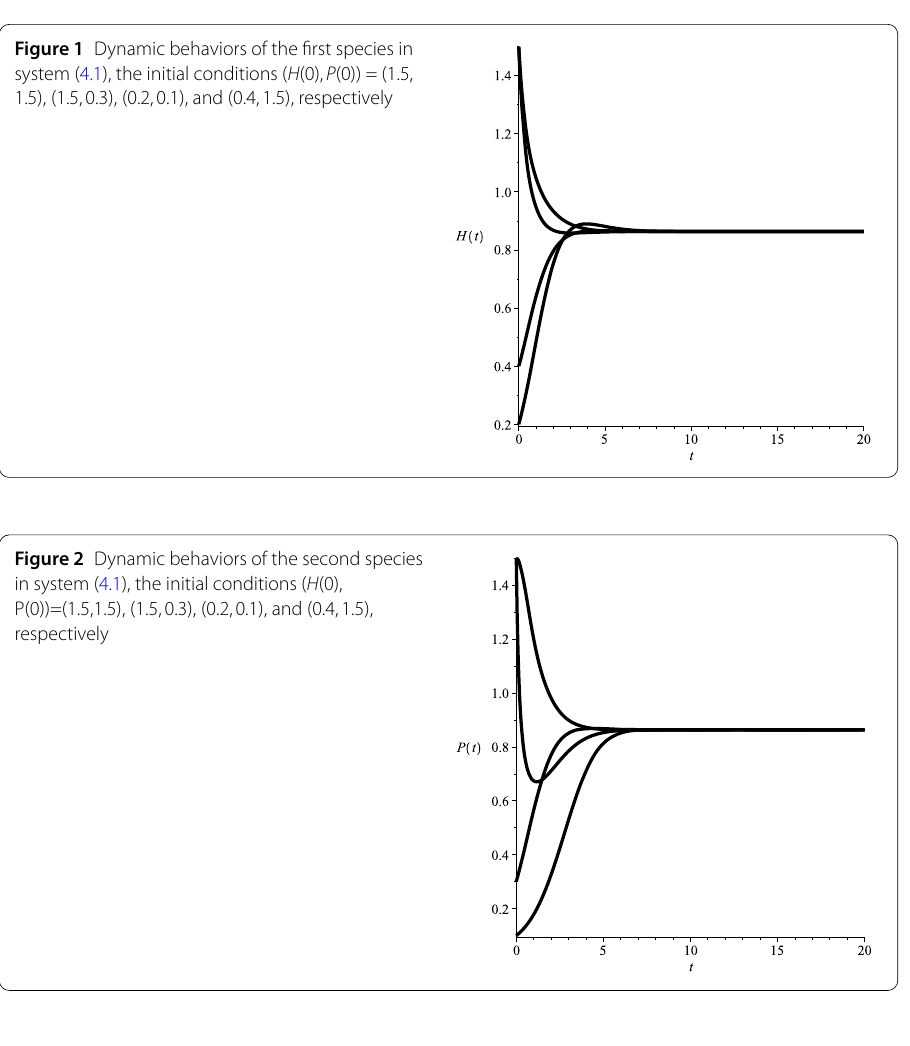
Figure 1 Dynamic behaviors of the first species in system (4.1), the initial conditions ( H (0), P (0)) = (1.5,